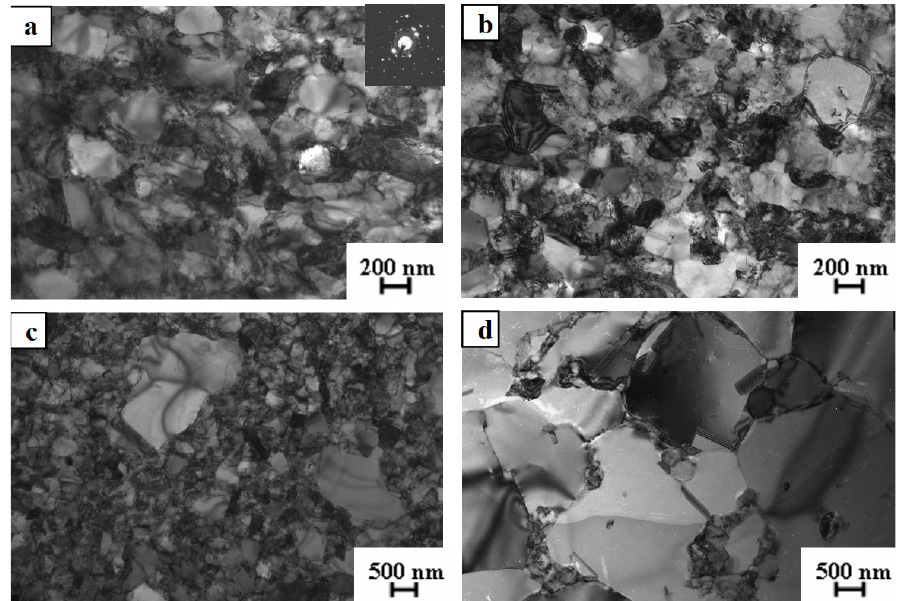
Figure 11. Microstructure of nickel after HPT ( a ) and subsequent annealing at the temperatures of 130 ( b ), 150 ( c ) and 175 °C ( d ) [86].